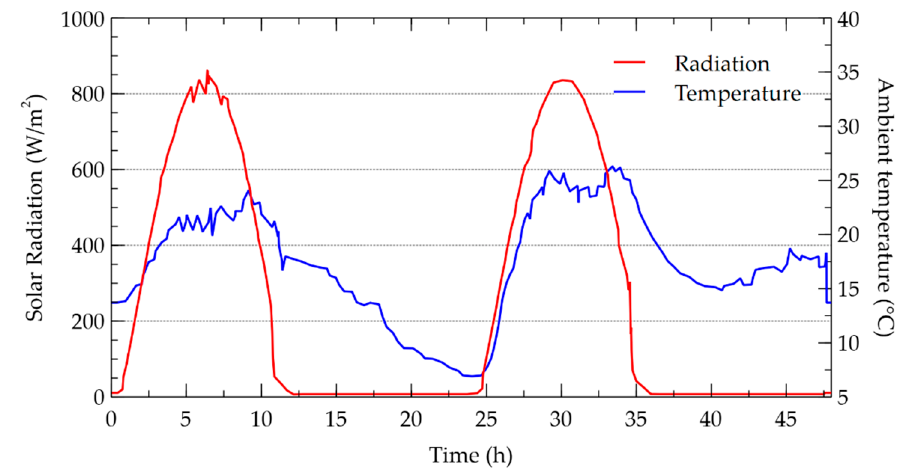
Figure 4. Operation conditions.